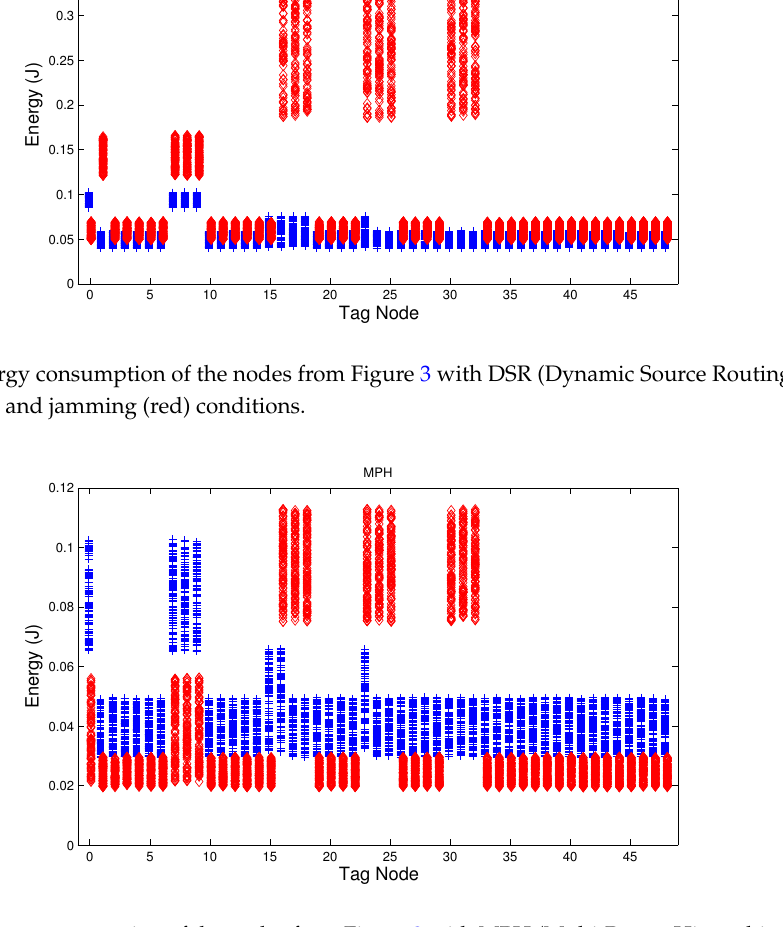
Figure 6. Energy consumption of the nodes from Figure 3 with MPH (Multi-Parent Hierarchical) under normal (blue) and jamming (red)